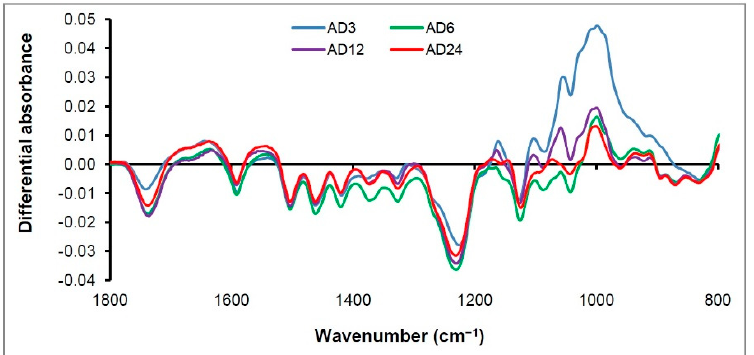
Figure 17. Differential FTIR spectra of maple wood samples.